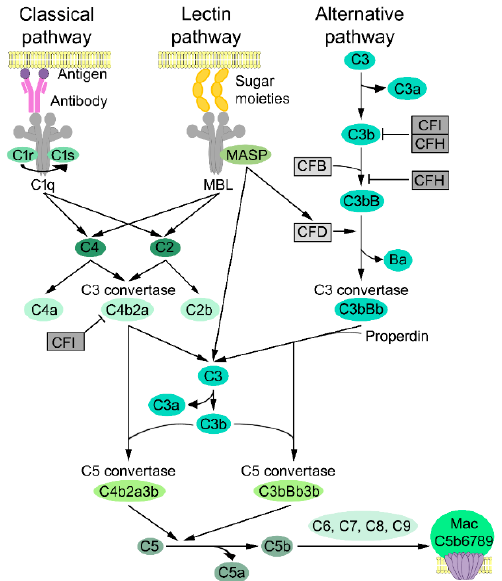
Figure 1. Complement cascade. The complement system can be activated via three major pathways. (1) The classical pathway is typically activated by antigen-antibody complexes on the cell surface. The C1 complex consists of C1q, C1r, and C1s molecules, and cleaves serum proteins C4 and C2. C4b binds to the target cell surface and C2a binds C4b and forms the complex C4b2a, which is a classical pathway C3 convertase. (2) The lectin pathway is activated by binding pattern-recognizing mannose-binding lectins (MBLs) to carbohydrate ligands on the surface of pathogens. Activated MBL-associated serine proteinase (MASP)-2 in the MBL-MASP-2 complex cleaves C4 and C2. The MASP-1 / 3 can activate complement factor D (CFD). (3) The alternative pathway is activated by any permissive surface. Constant spontaneous breakdown of C3 takes place at a low level in plasma and by the surfaces of microbes and generates C3b. Complement factor B (CFB) binds to C3b and forms a complex C3bB. Complement factor D (CFD) cleaves CFB to Ba and Bb. The fragment Bb stays attached